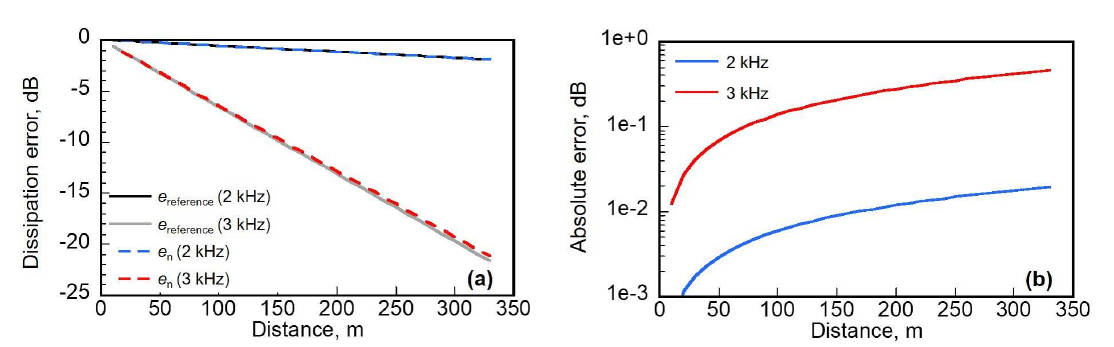
Figure 7. Theoretical and numerical dissipation errors: ( a ) e reference vs. e n at 2 kHz and 3 kHz and ( b ) absolute errors from e reference at 2 kHz and 3